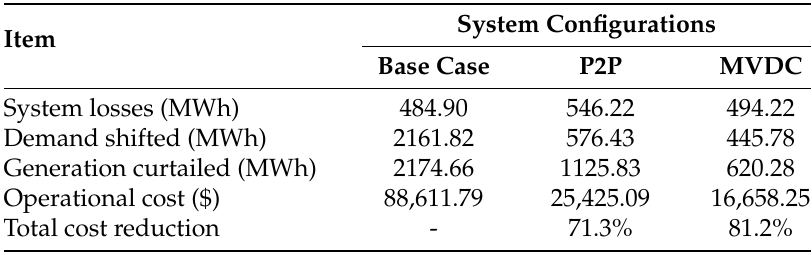
Table 4. A comparison in minimising the operation